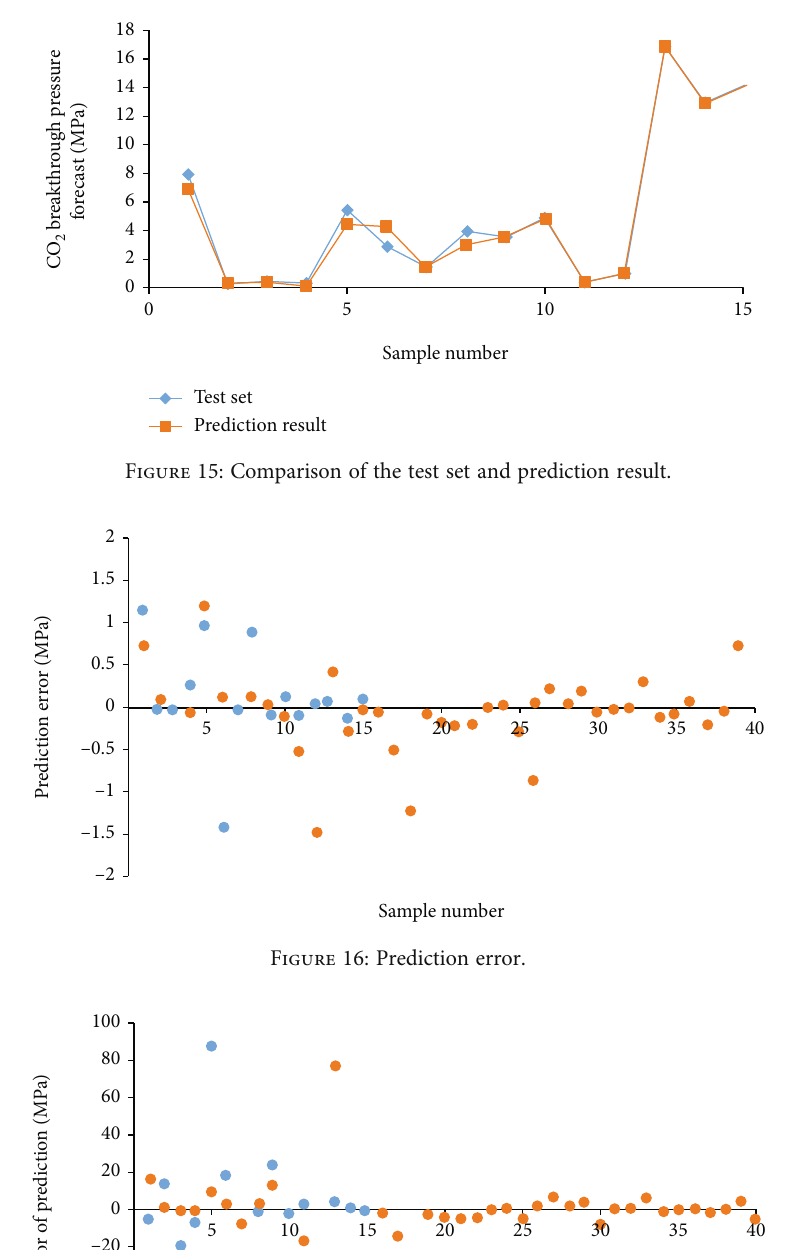
Figure 16: Prediction error.